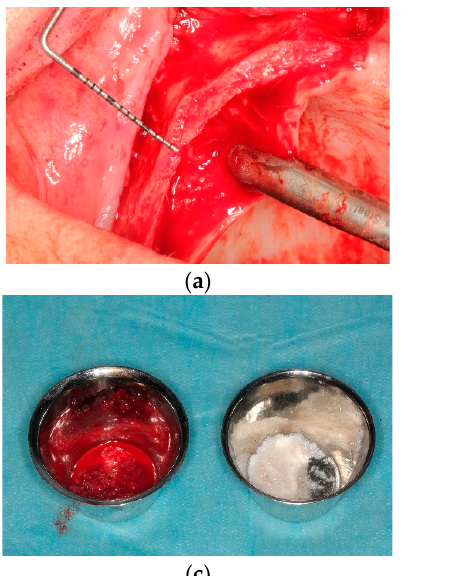
Figure 1. Examples of CS application (test group): ( a ) pre-treatment clinical situation; ( b ) decortication of residual alveolar bone; ( c ) harvesting particulated autogenous bone; ( d ) fixation of CS with two osteosynthesis screws; ( e ) mixture of ABB and autogenous grafts; ( f ) closure of augmentation areas with resorbable membrane; ( g ) suturation.